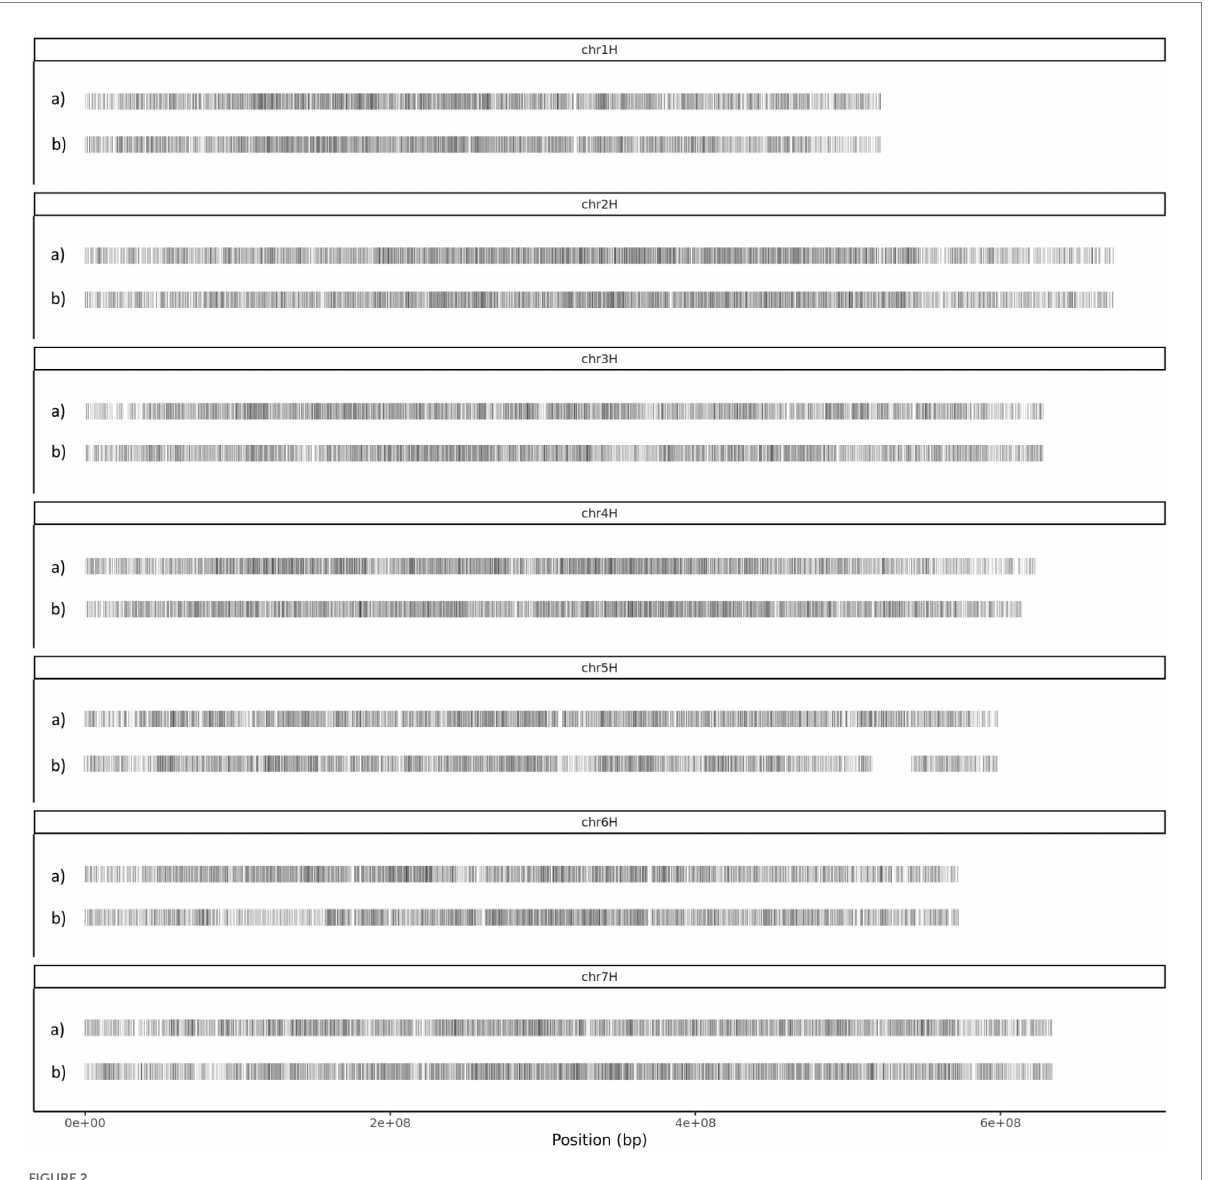
In total 25 individuals for Bowman.M3 and 25 individuals for BW230.M3 were analysed as described above and shown in Figure 3 (all remaining plots with the CO positions highlighted in Supplementary material 1). Combining all results and calculating the number of CO for each individual plant led to an average 20.16 ± 3.1 COs in Bowman.M3 and 10.64 ± 2.9 CO for BW230.M3 (Figure 6C). Plotting the average number of CO along the physical chromosome map split into 2 per cent intervals showed a higher number of COs towards the telomeric ends and a pericentromeric region almost completely depleted of COs (Figure 6A). For some of the individual chromosomes (Supplementary material 2) the first 2% of the chromosomes had a higher number of CO events in the BW230 in comparison with the wildtype, but for the remaining 98% the wildtype showed a higher number of